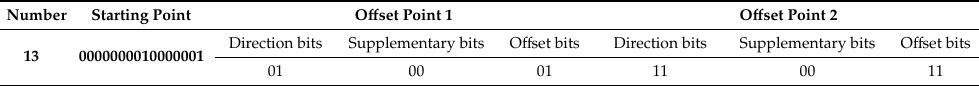
Table 3. Line or polygon feature binary offset format.